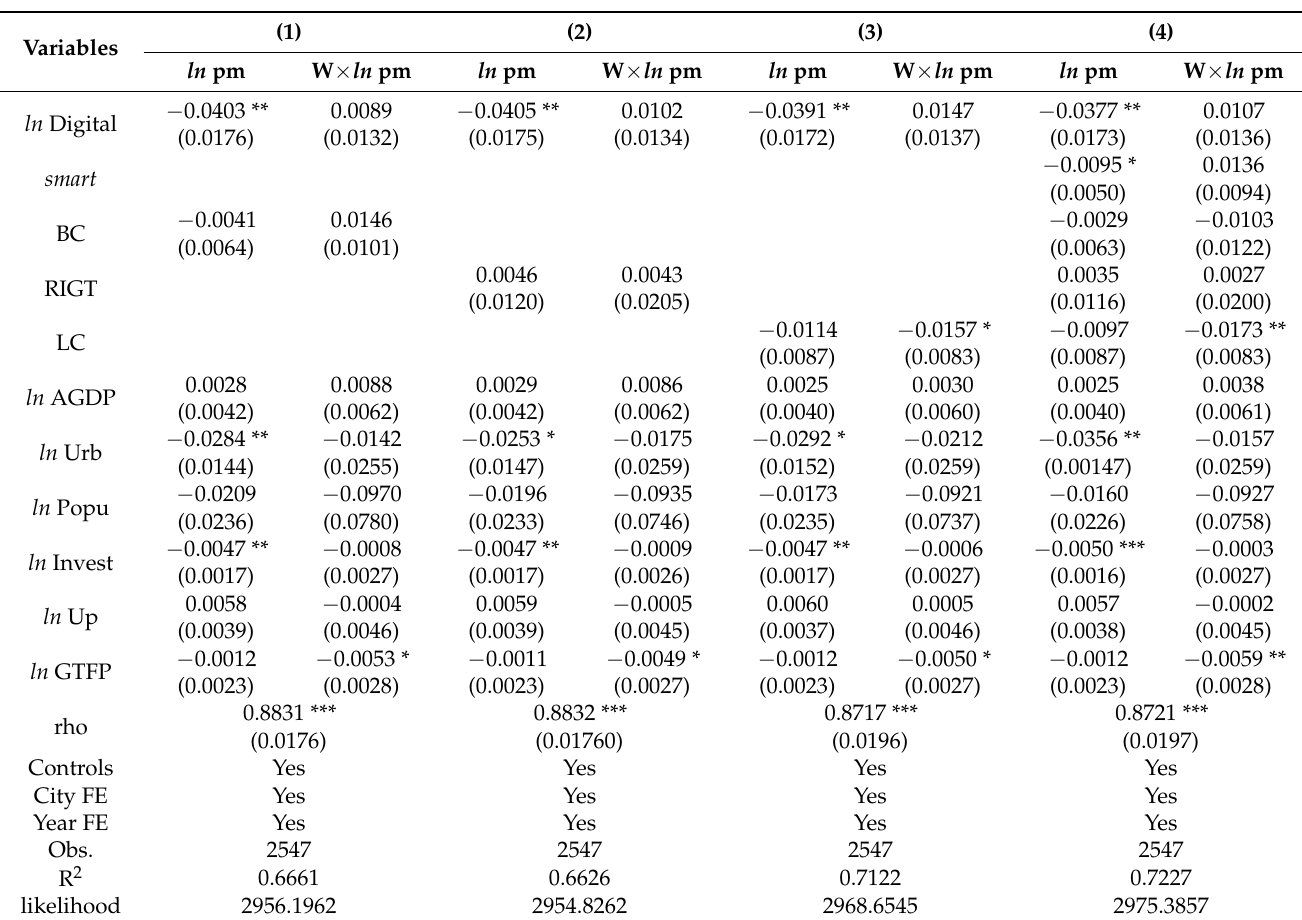
Table 8. Excluding the other policies